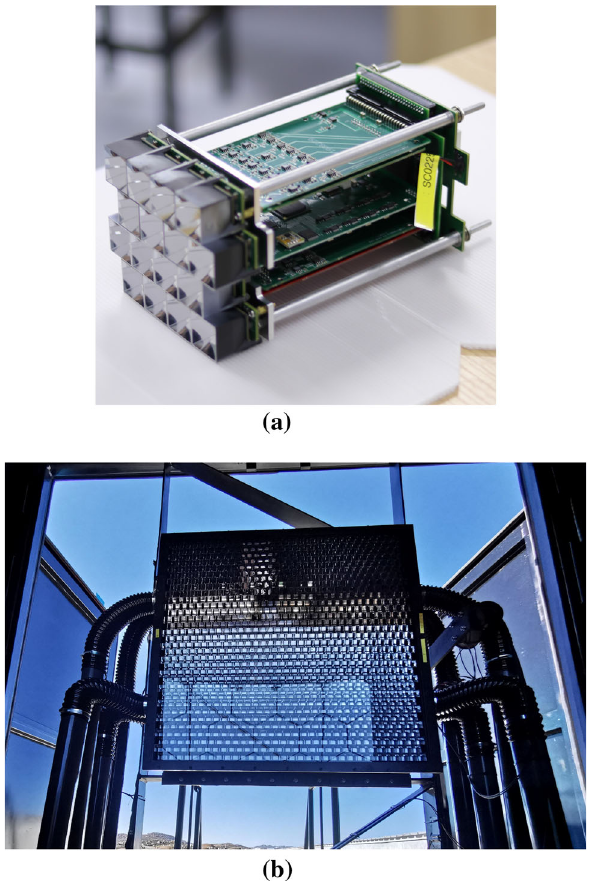
Fig. 17 An assembled sub-cluster ( a ) and a camera in the telescope ( b )